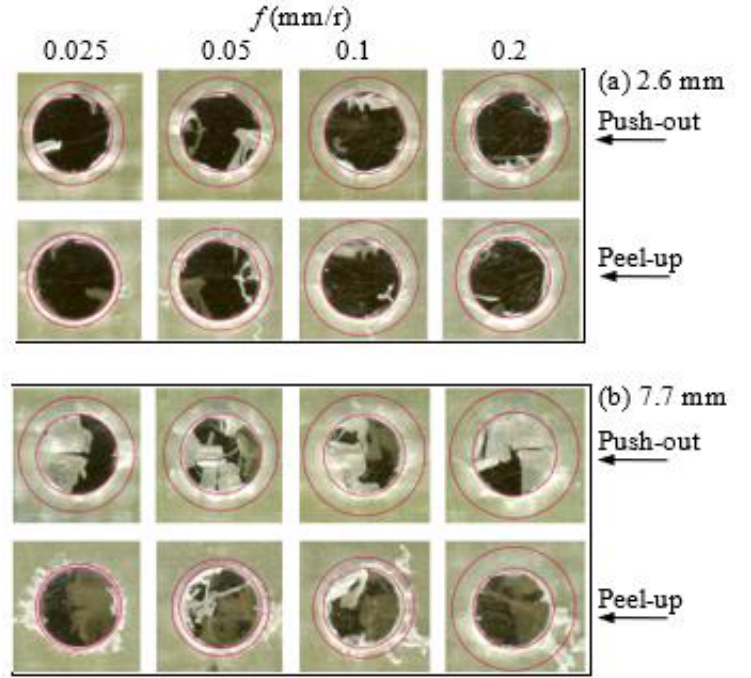
Figure 13. Representative samples of delaminations in the drilling of GFRP laminate at a speed of 1600 rpm: ( a ) t = 2.6 mm and ( b ) t = 7.7 mm.